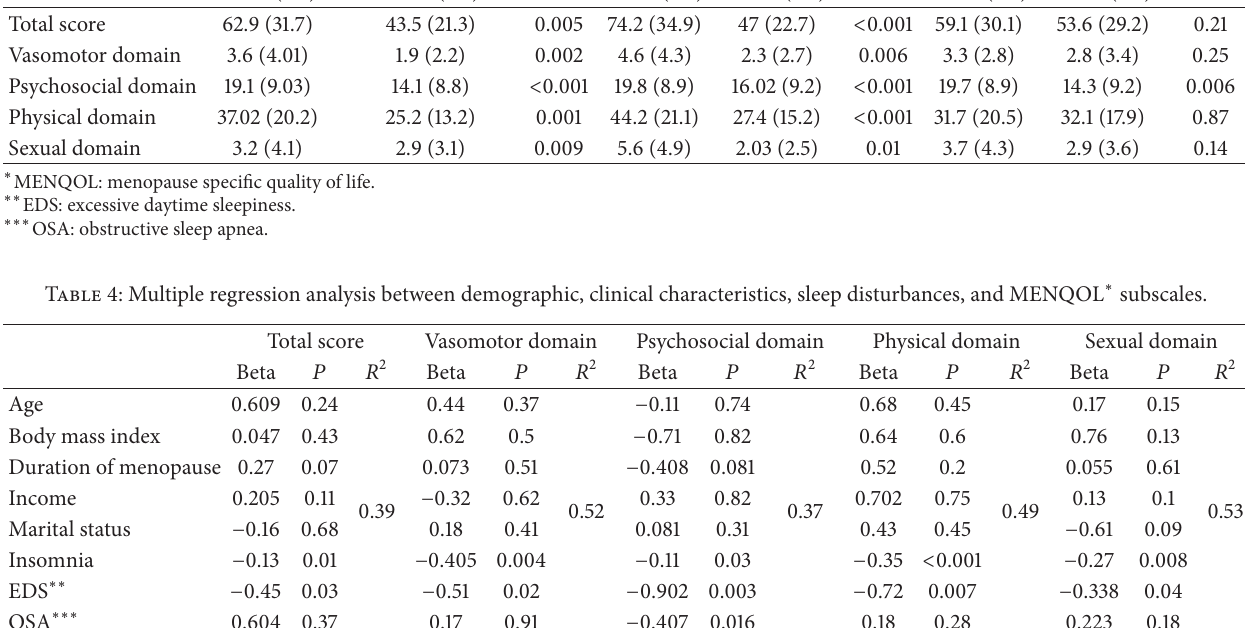
With EDS Without EDS 𝑃 With OSA Without OSA 𝑃 value value value